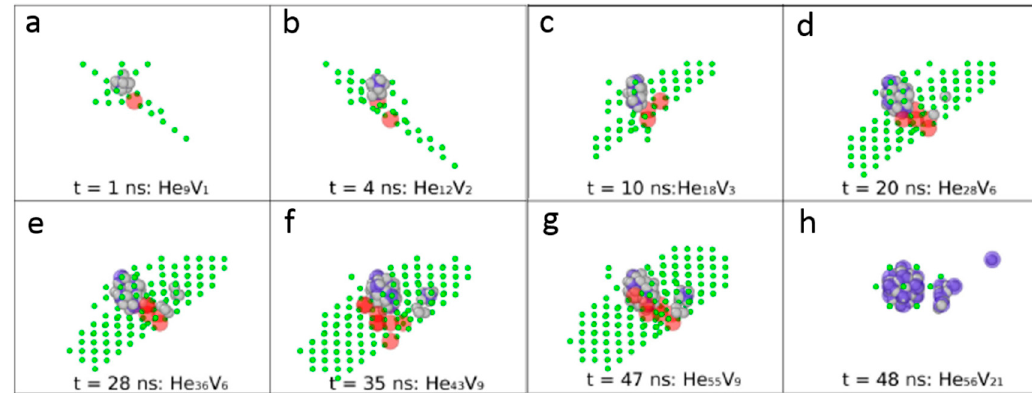
Figure 4. The evolution process of a bubble network at 1000 K with an insertion rate of 1 × 10 9 He/s in tungsten. ( a ) Formation of the first Frenkel pair and He 9 V 1 cluster; ( b ) Another Frenkel pair is formed with further inserted of He atoms with two interstitials staying in two adjacent <111> rows; ( c,d ) More Frenkel pairs are created around the central He–V cluster; ( e ) New He cluster containing three He atoms is formed; ( f,g ) He clusters promote Frenkel pairs formation. ( h ) He bubbles in the matrix. Gray, red and blue dots represent He atoms, tungsten interstitials and vacancies, respectively. Reprinted with permission from [33]; Copyright 2018 Elsevier.